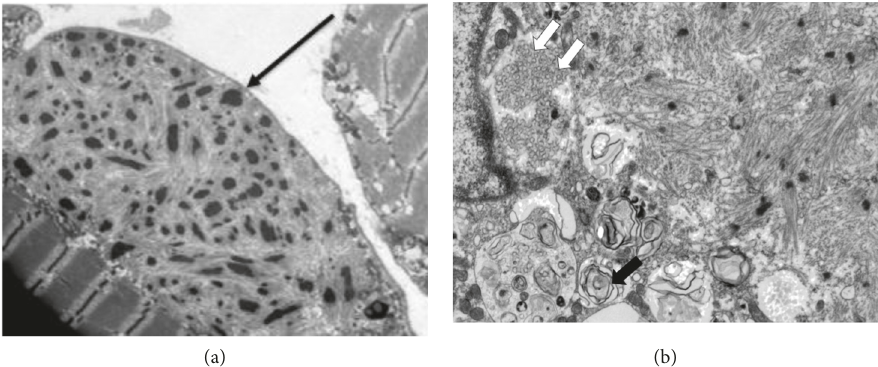
Figure 3: On the left (a), an electron micrograph of skeletal muscle biopsy with Nemaline rod (black arrow). On the right (b), an electron micrograph of the myeloid body, black arrow and curvilinear bodies (white double